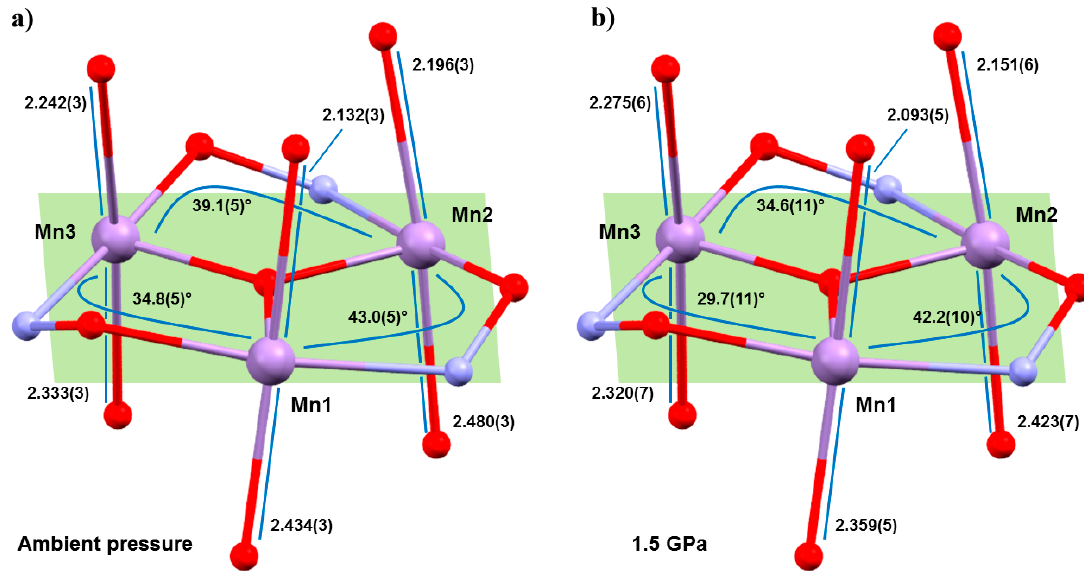
Figure 3. Comparison of Jahn–Teller bond lengths and Mn–O–N–Mn torsion angles in 1 at ( a ) ambient pressure and ( b ) 1.5 GPa. Colour code as Figure 1.